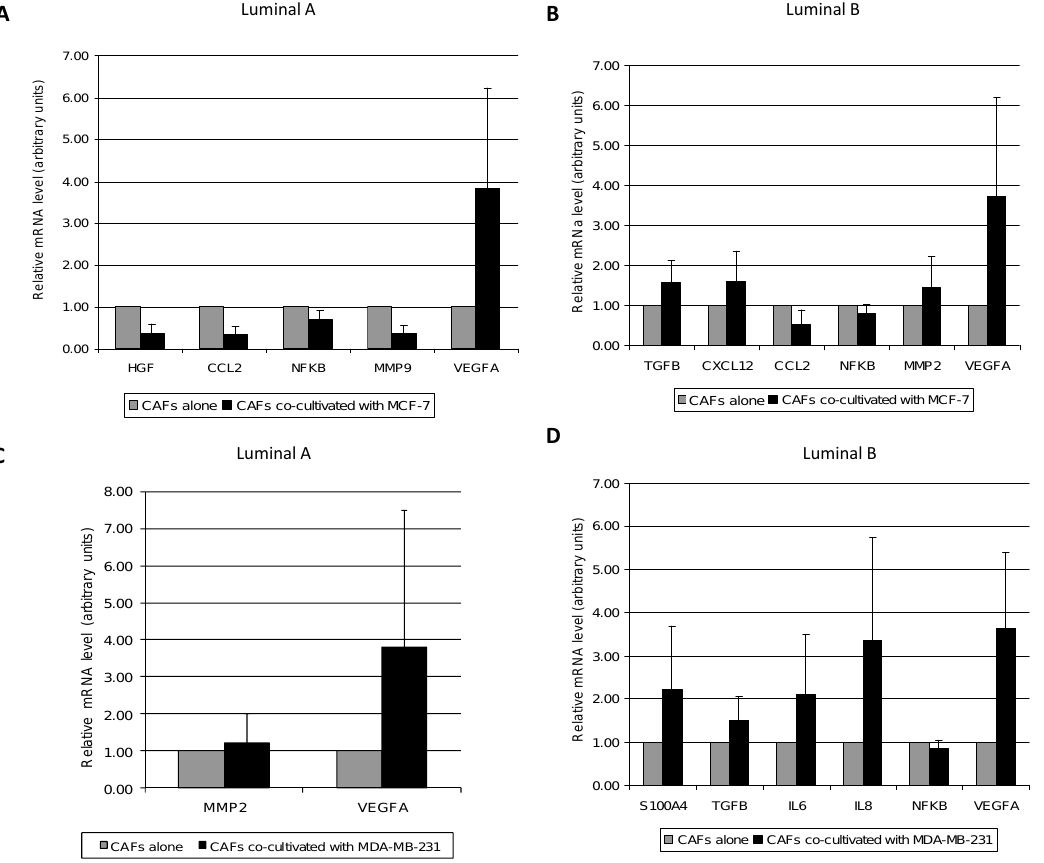
Figure3. Real-timePCRanalysisoffactorsassessedbetween: ( A )CAFsfromLuminalAtumorscultured alone or co-cultured with MCF-7, ( B ) CAFs from Luminal B tumors cultured alone or co-cultured with MCF-7, ( C ) CAFs from Luminal A tumors cultured alone or co-cultured with MDA-MB-231, ( D ) CAFs from Luminal B tumors cultured alone or co-cultured with MDA-MB-231. Data represent the mean ± SD. Only factors with significant di ff erential expression are represented. p values are indicated in the text. Values are normalized to CAFs alone. For this analysis, performed in triplicate, all 19 patients were